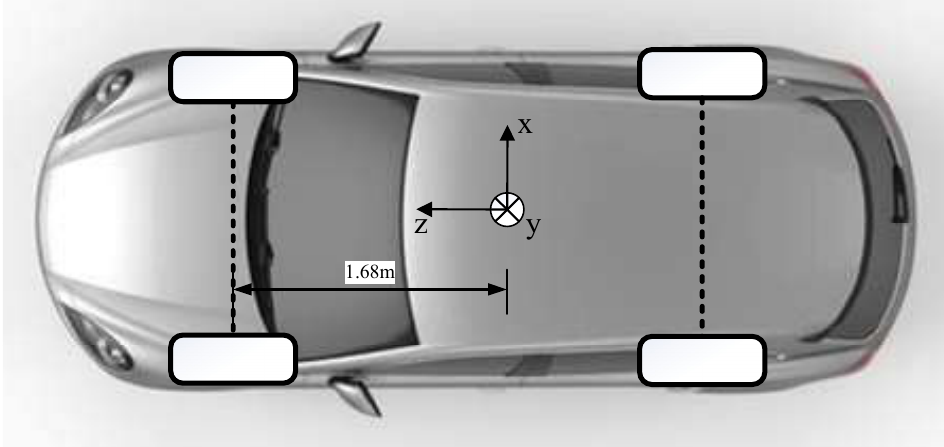
Figure 3. The Velodyne coordinate system of the KITII dataset. z -axis points in the direction of motion of the vehicle, and the x -axis is the direction perpendicular to it. The direction of the y -axis is